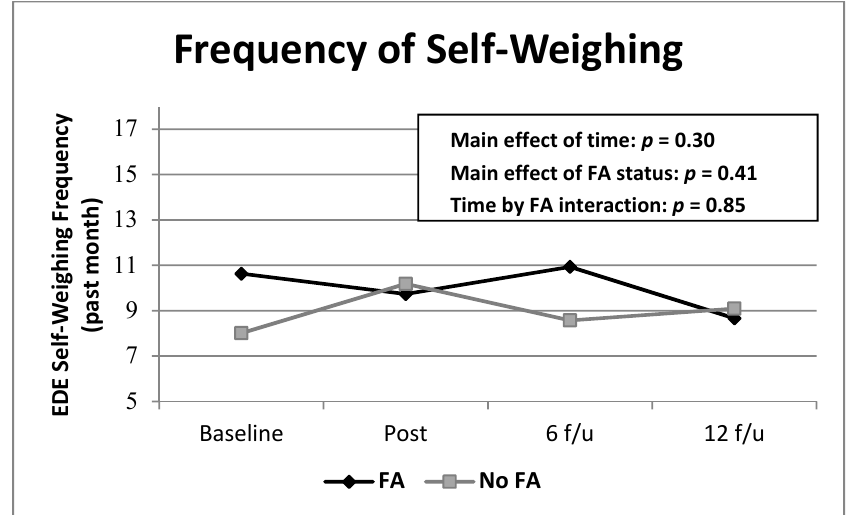
Figure 3. Frequencies of EDE Self-Weighing scores over time by food addiction group. Note. Means were derived from raw data for ease of interpretation. EDE = Eating Disorder Examination; FA = food addiction. All non-significant differences.